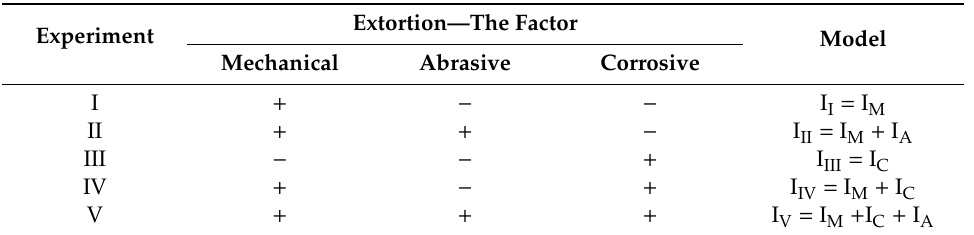
Table 6. Methodological options of elementary tests [41].